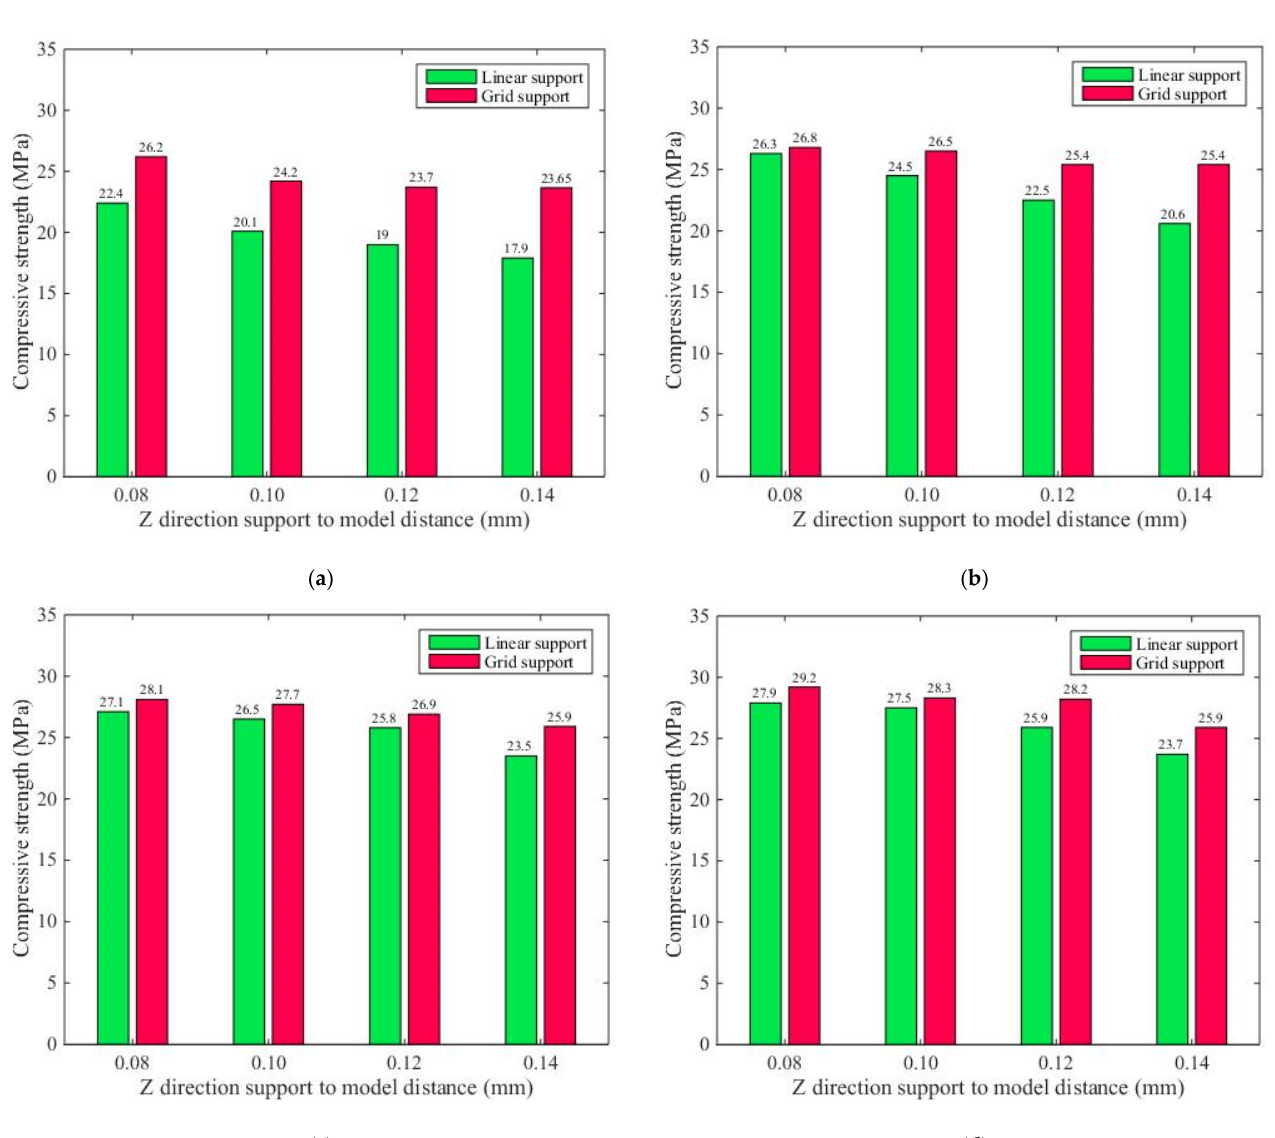
Figure 15. Comparative analysis of the experimental results for the compressive strengths of the two support models with the same support density and different support distance models in the Z direction: ( a ) the supported member printing 30% of the support density of the foundation; ( b ) the supported member printing 50% of the support density of the foundation; ( c ) the supported member printing 70% of the support density of the foundation; ( d ) the supported member printing 90% of the support density of the foundation.